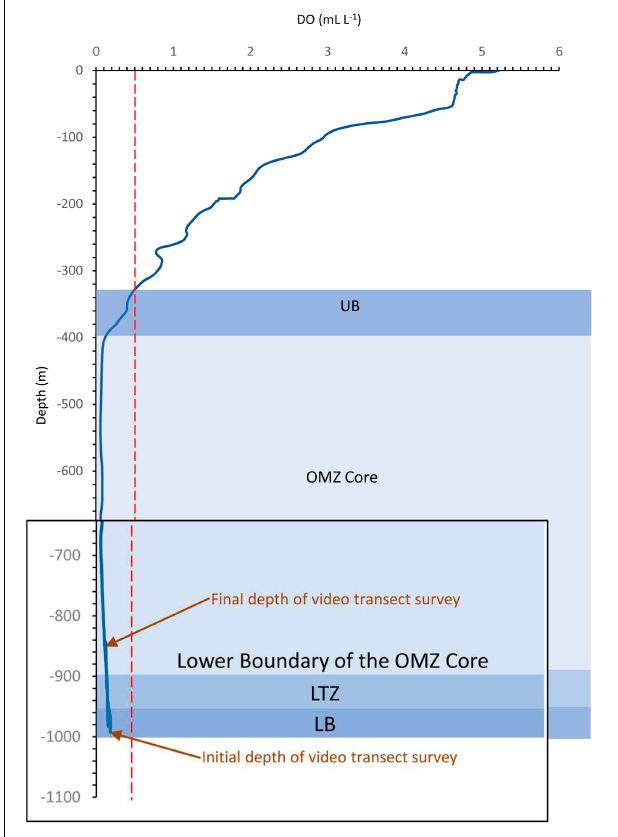
FIGURE 3 | Dissolved oxygen profile during dive D347 in the NW limit of Guaymas Basin and the Sonoran Margin. Oxygen minimum zone (OMZ) where dissolved oxygen (DO) is < 0.5 mL L - 1 ; red dotted line represents the limit where DO = 0.5 mL L - 1 ; LB = lower OMZ boundary; LTZ = lower OMZ transitional zone; UB = upper boundary of the OMZ. Note the magnifying over OMZ survey